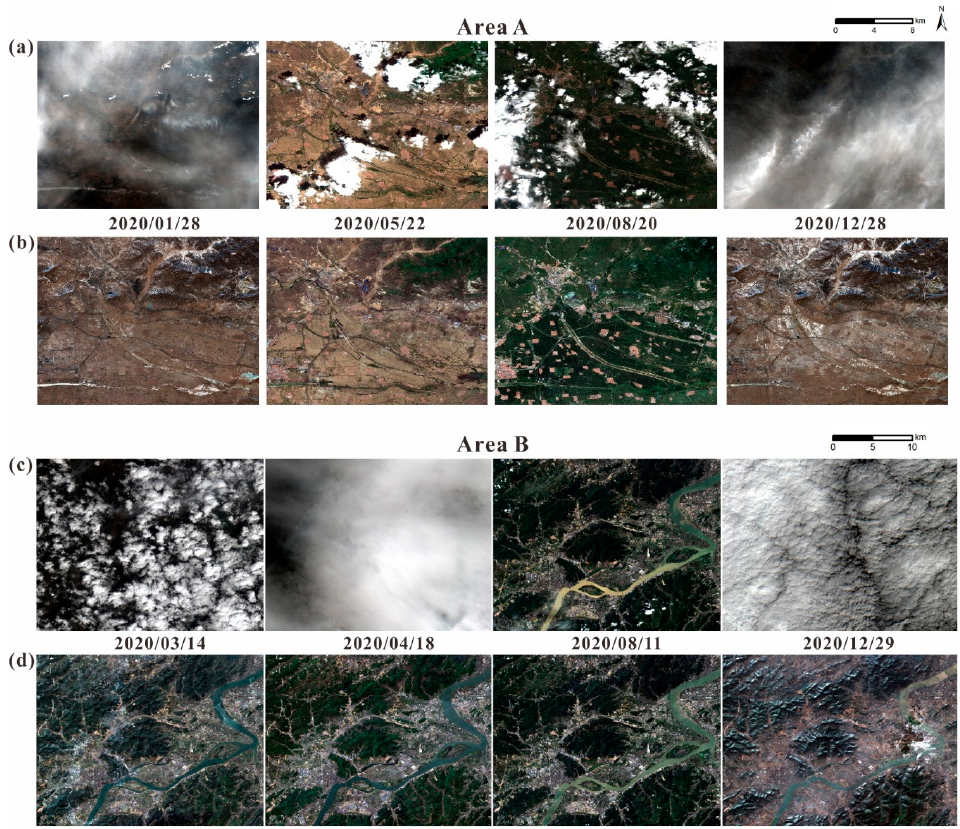
Figure 12. Comparisons of actual cloud-contaminated Sentinel-2 images and reconstructed images over the Area A and B. ( a ) Cloud-contaminated Sentinel-2 images on different dates in the Area A; ( b ) Sentinel-2 images in the Area A reconstructed by the DCT-PLS method. ( c ) Cloud-contaminated Sentinel-2 images on different dates in the Area B; ( d ) Sentinel-2 images reconstructed in the Area B by the DCT-PLS method.